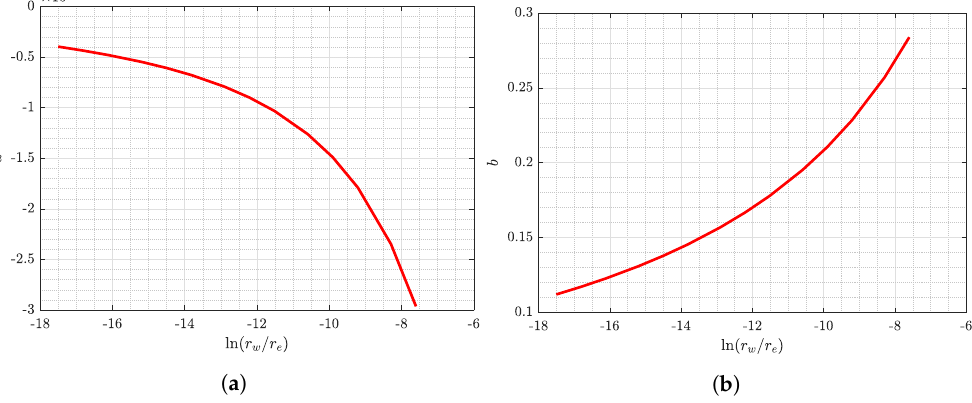
Figure A7. Fitting parameters ( a ) a and ( b ) b versus ln r w / r e .